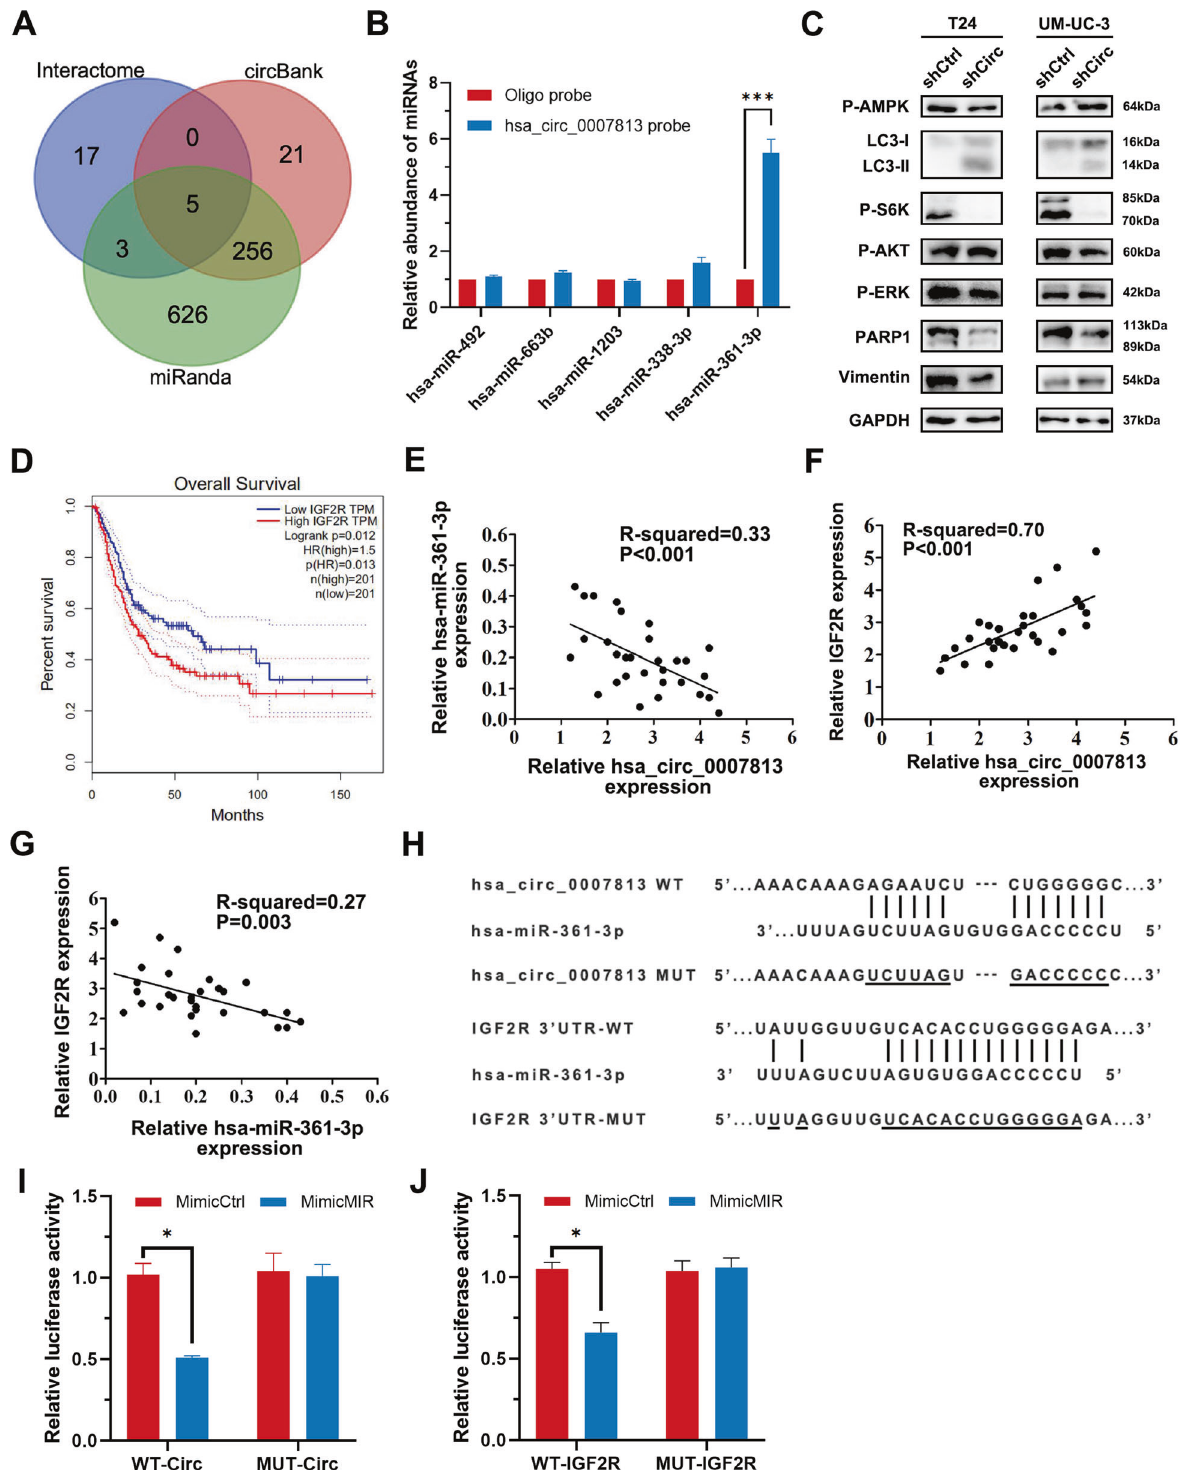
assays (Supplementary Fig. S1G), wound healing assays (Supplementary Fig. S1J), and Transwell assays (Supplementary Fig. S1M). Results showed that the proliferation, migration, and invasiveness inhibitory effects caused by hsa_circ_0007813 knockdown could be rescued by hsa-miR-361-3p